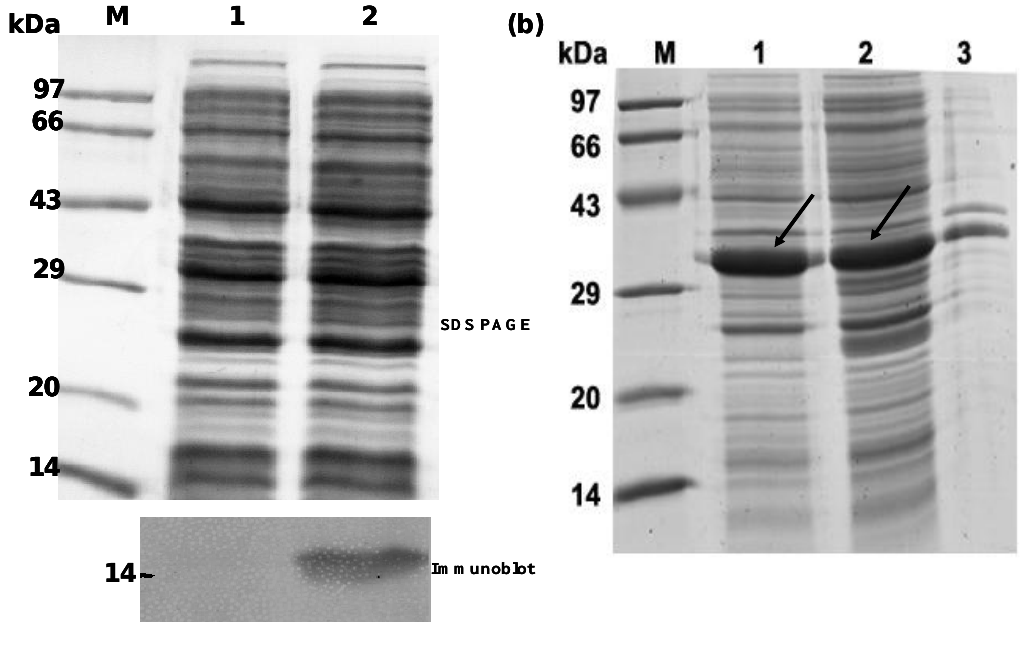
Figure 1. Expression analysis of pET21a-hGMCSF and pET32a-hGMCSF. ( a ) Upper Panel: SDS-PAGE analysis of pET21a-hGMCSF expression in BL21 DE3 codon plus cells with IPTG induction, showing absence of visible expression. Lane M: molecular weight Marker; lane 1: Empty vector control; lane 2: expression from pET21-hGMCSF. Lower Panel: Immunoblot using mouse monoclonal anti-hGMCSF antibody showing low expression level of hGMCSF; ( b ) SDS-PAGE analysis of TRX-hGMCSF fusion protein expression. The pET32a-hGMCSF construct was transformed into BL21 (DE3) codon plus cells. The cells were induced with 1 mM IPTG for 3 h. Lane M: Molecular weight Marker; lane 1: Crude cell lysate; lane 2: Soluble fraction and lane 3: Insoluble fraction. Arrows indicate TRX-GMCSF